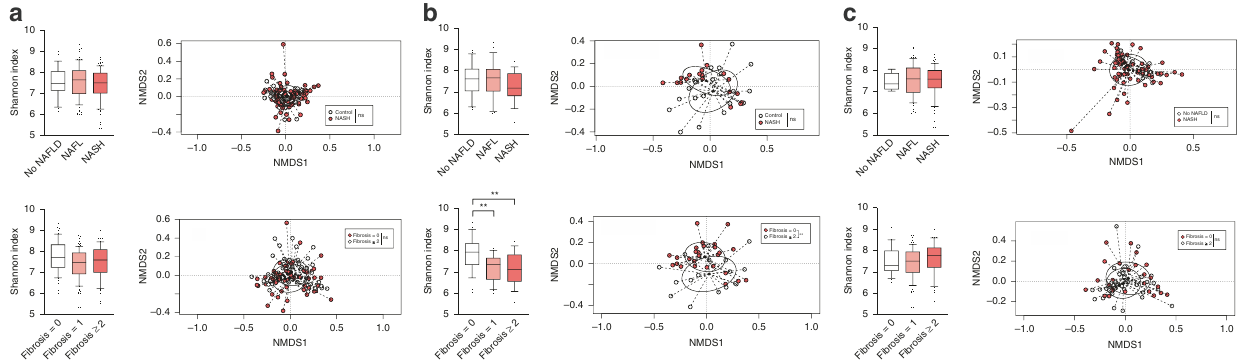
Fig. 1 Comparison of the diversity of gut microbial communities in all, non-obese, and obese subjects. The alpha and beta diversity of a all ( n = 202), b non-obese subjects ( n = 64) (** P = 0.0074, F0 vs F1; ** P = 0.0084, F0 vs F2 – 4), and c obese subjects ( n = 138) divided by the histological spectra of NAFLD or fi brosis severity. Alpha diversity was based on the Shannon index with 12,000 rare fi ed sequences per sample. The box plots indicate the median, 25th to 75th percentiles (boxes), and 10th to 90th percentiles (whiskers). Statistical analysis was performed using a two-sided nonparametric Mann – Whitney test or a nonparametric Kruskal – Wallis test with Dunn ’ s multiple comparison test. NMDS plots were generated using relative OTU abundance data according to the Bray – Curtis distance, and statistical signi fi cance was measured using adonis analysis (panel b ; * P = 0.038, F0 vs F2 ( Ruminococcaceae ), Coprococcus , and Lachnospira ( Lachnospir- aceae ) were signi fi cantly depleted in the signi fi cant fi brosis group